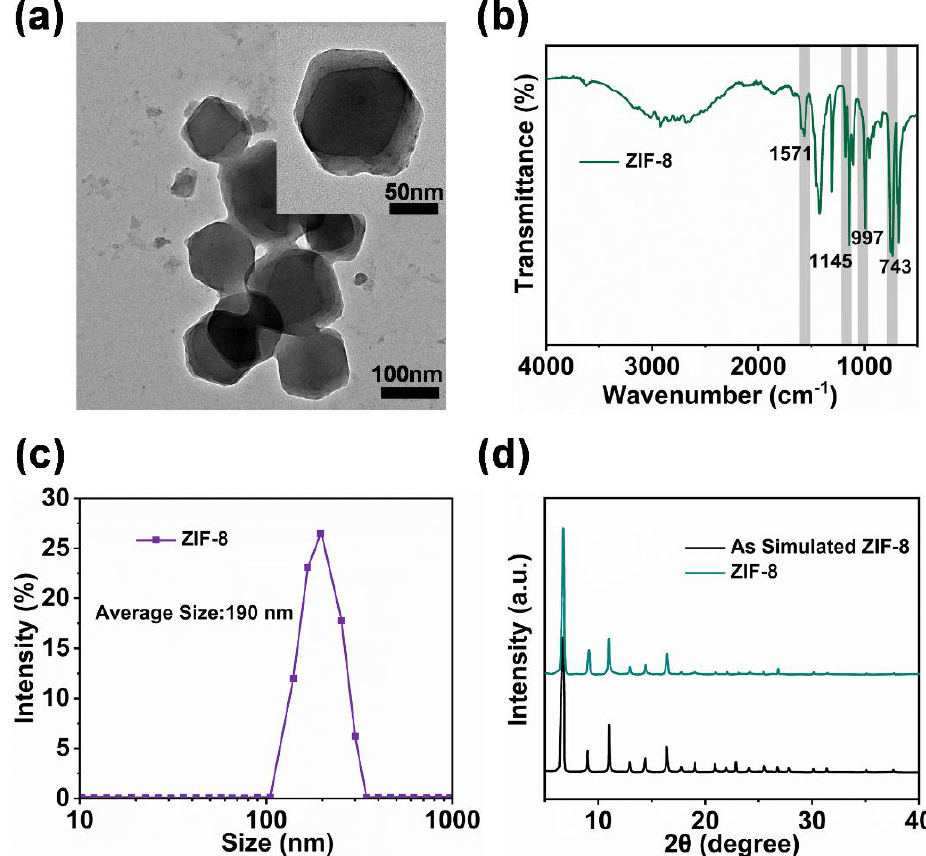
Figure 2. ( a ) TEM images, ( b ) ATR-FTIR spectra, ( c ) DLS measurement image, and ( d ) XRD patterns of ZIF-8 particles.